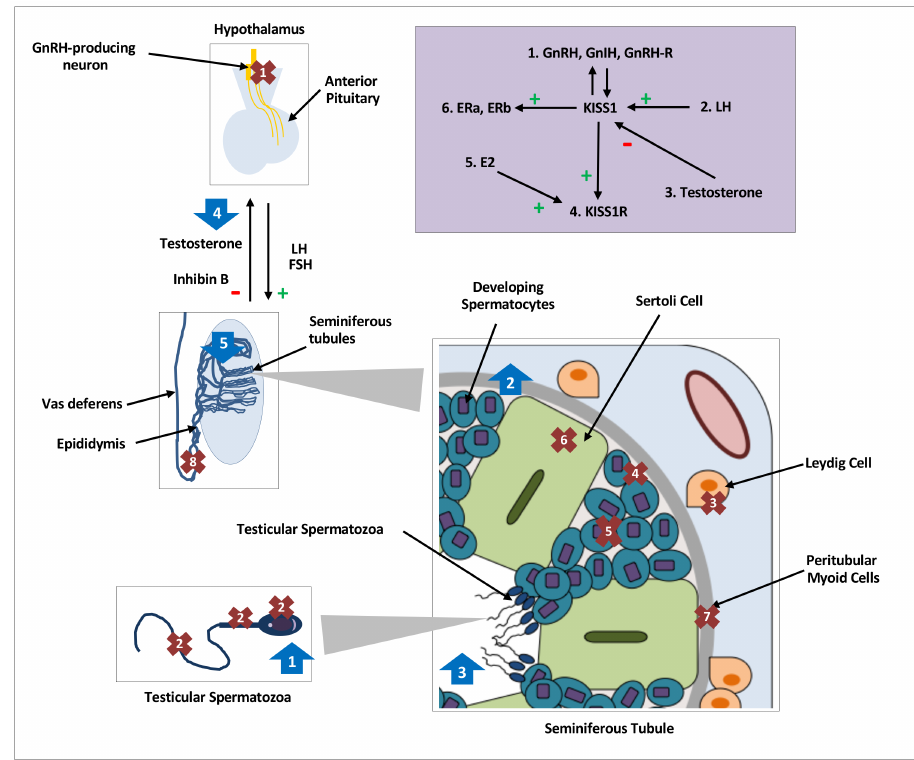
Figure 1. Distribution, regulation and e ff ects of kisspeptin on testicular function in various species. Distribution and expression of testicular KISS1 / KISS1R, denoted by crosses 1–8, regulation of testicular kisspeptin signaling, denoted by the purple shaded box and e ff ects of kisspeptin on testicular